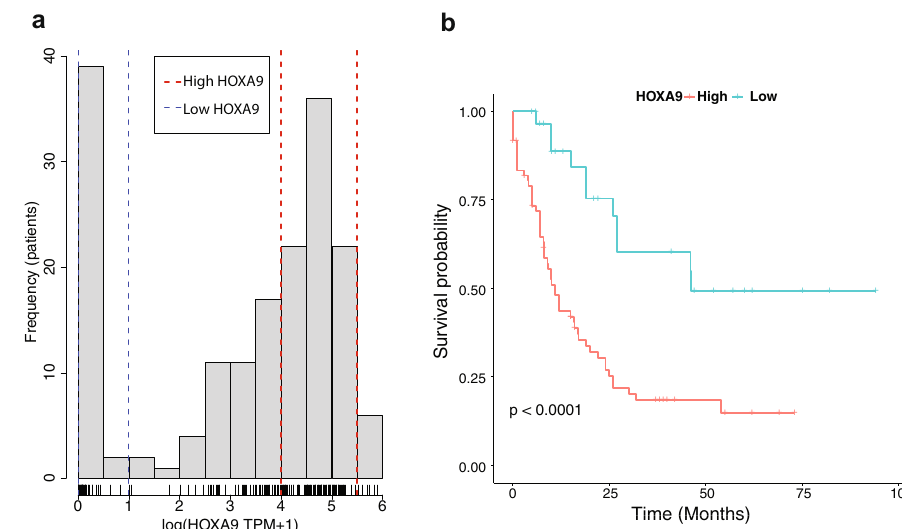
Fig. 2 | HOXA9 low and high expression strati fi es patients in AML. a HOXA9 expression in AML patients is signi fi cantly bimodal (unimodality test rejected with p < 2 : 2×10 (cid:1) 16 ), suggesting a role as a genetic switch. The low peak consists of 31 patients for HOXA9 expression between 0.005 – 1log (TPM+1) and 80